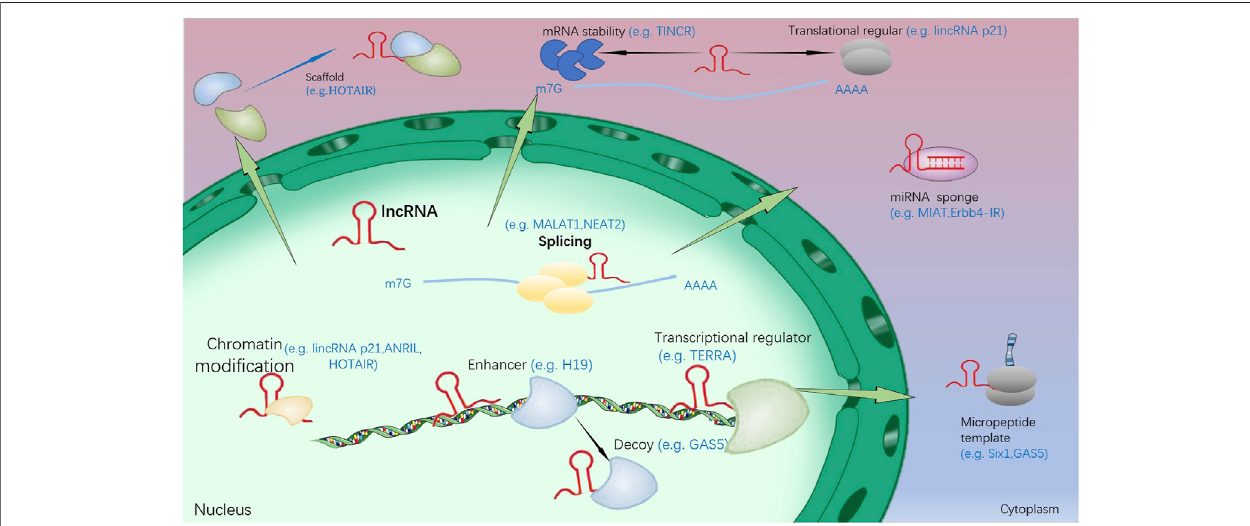
FIGURE 2 | The function and regulation mechanism of lncRNA. (1): In the nucleus, lncRNA could inhibit and/or activate gene expression by transferring chromatin modi fi ersandvarioustranscriptionalregulatorsintoDNA.Inaddition,targetgeneactivationcouldbefurtherenhancedbylncRNA.Theycanalsoinduceproteinstomove awayfromspeci fi cDNAlocationsandpassasmoleculardecoys.(2):Inthecytoplasm,lncRNAcouldbringtwoormoreproteinsintoacomplexbyactingasascaffold.In addition, they could regulate other transcripts or proteins by acting as sponges and protein templates, or regulating mRNA degradation and translation.